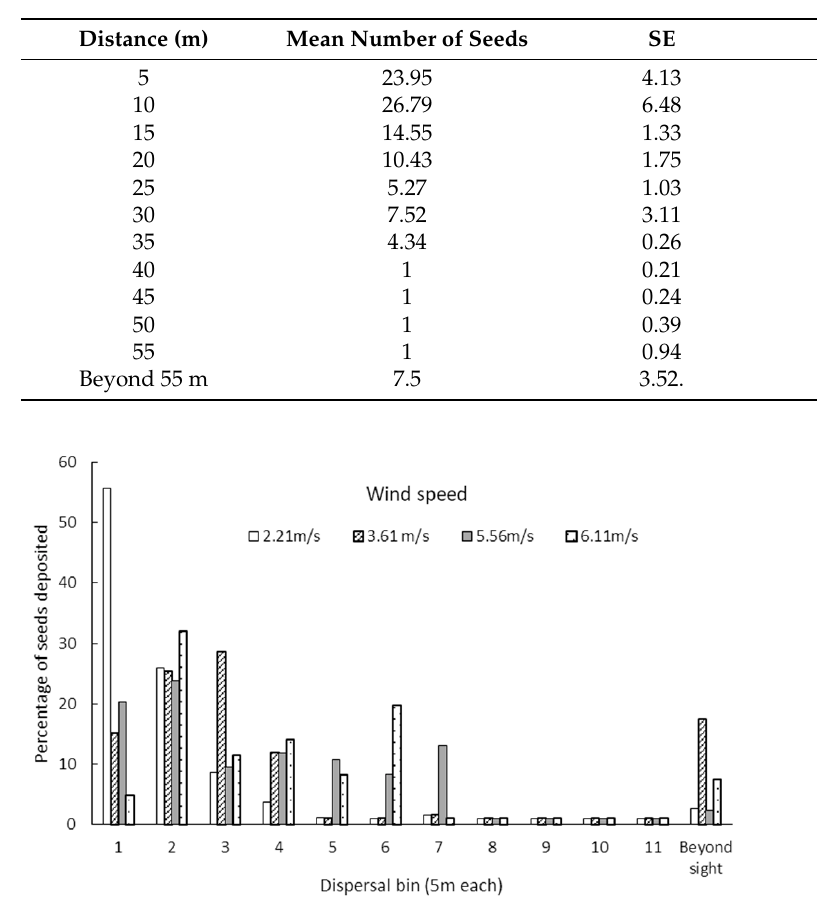
ment (Table 2). The results showed that at all wind speeds, short-distance seed dispersal is best described by a unimodal hump-shaped distribution.